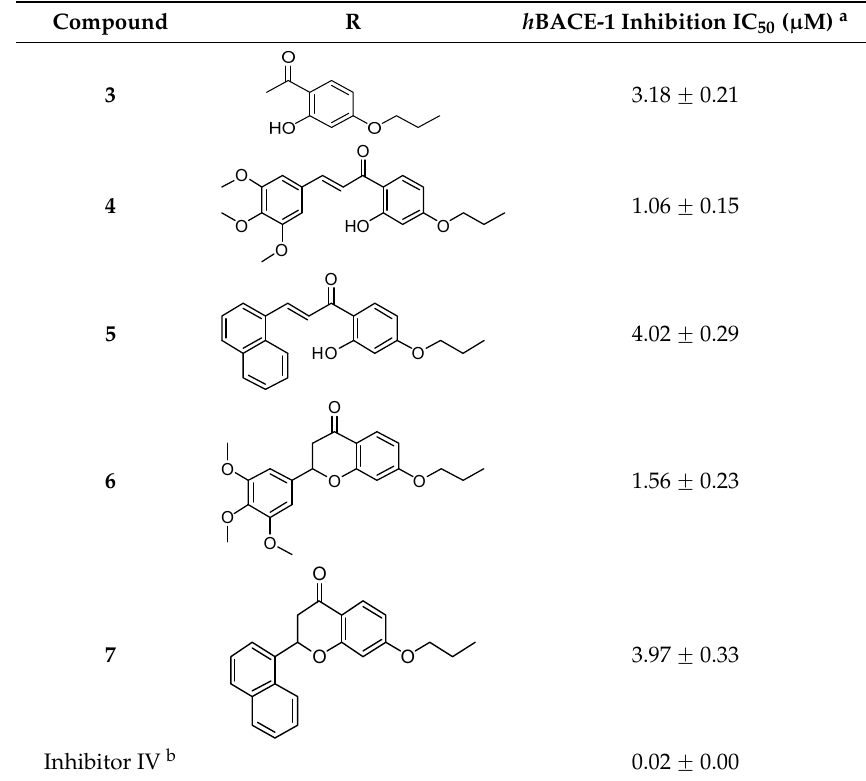
Table 2. Neurotoxicity and Cu(II) chelating activity of the studied compounds and positive control Na 2 EDTA.